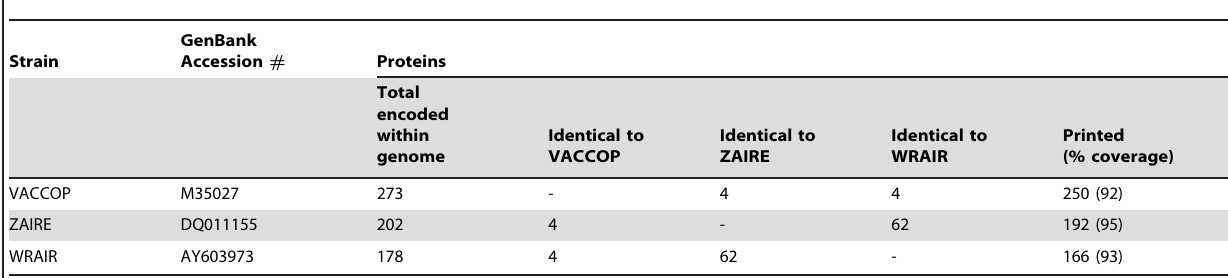
Table 1. Orthopoxvirus microarray proteome coverage. *